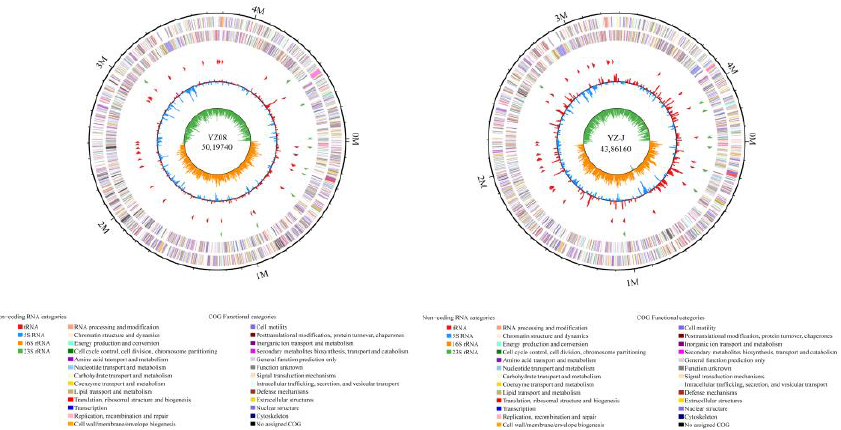
Figure 1. Map of the circular genome of Shewanella putrefaciens YZ08 and YZ-J. Genome size (first circle); coding DNA sequences on forward and reverse chains based on COGs categories (second and third circles); forward strand and reverse strand non-coding RNA (ncRNA) (fourth and fifth circle); guanine-cytosine (GC) content (sixth circle) and GC skew (fifth circle).